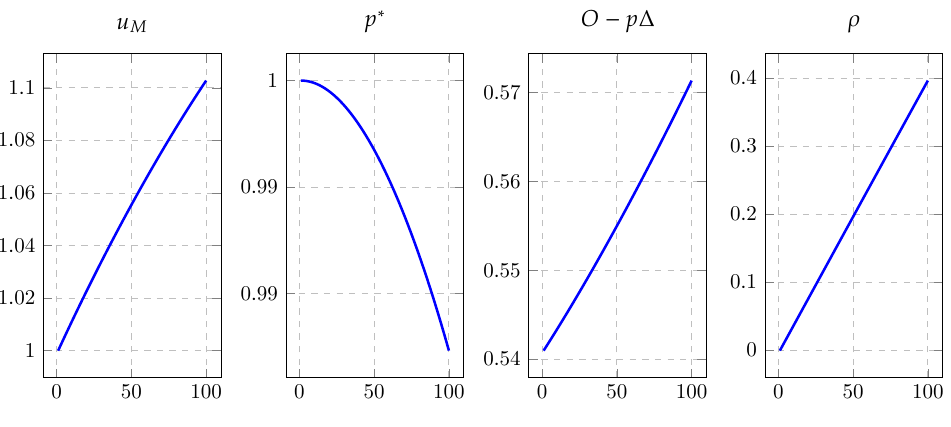
Figure 1. Equilibrium of mask shortage.